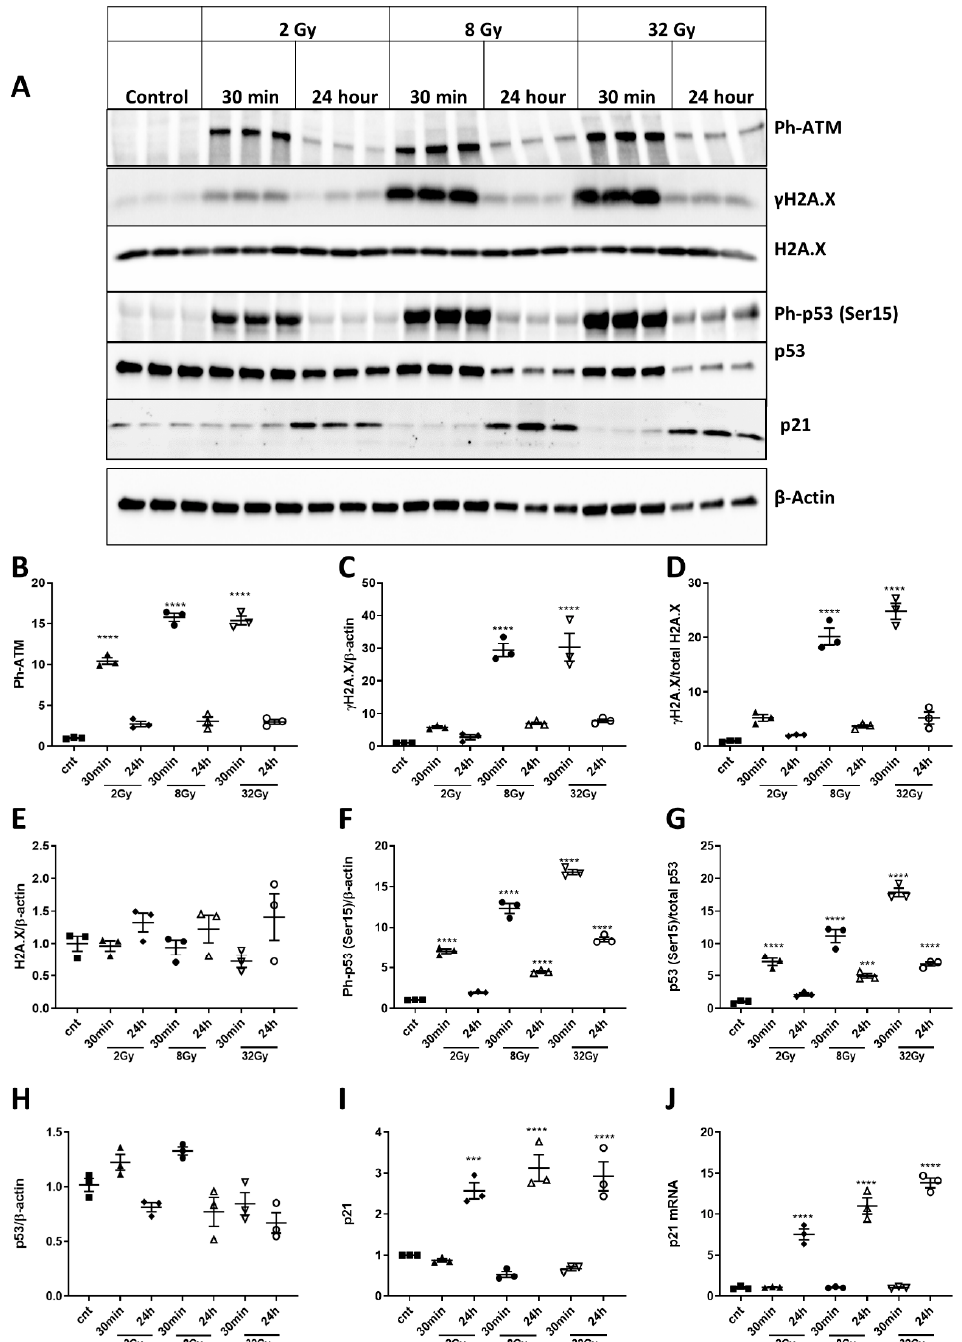
Figure 3. Ionizing radiation (IR) induces rapid and dose-dependent activation of DNA-damage and p53 pathways in primary cortical neurons. ( A ) Western blots for Ph-ATM(Ser 1981), γ -H2A.X, p53 and p21. ( B ) Ph-ATM (Ser1981) (F(6,14) = 246.4, p < 0.0001 for 30 min 2, 8 and 32Gy, compared to control; p = 0.0384 for 24 h 8Gy, p = 0.0483 for 24 h 32Gy, compared to control; p < 0.0001 for 24 h groups, compared to 30 min for 30 min 8Gy, compared to 30 min 2Gy. ( C ) γ -H2A.X (F(6,14) = 47.02, p < 0.0001 for 30 min 8 and 32Gy compared, to control; p < 0.0001 for 30 min 8Gy compared to 30 min 2Gy). ( D ) γ -H2A.X normalized to total H2A.X (F 6,14) = 102.2, p < 0.0001 for 30 min 8 and 32Gy, compared to control; p < 0.0001 for 30 min 8Gy, compared to 30 min 2Gy; p = 0.045 for 30 min 32Gy, compared to 30 min 8Gy). ( E ) H2A.X normalized to β -actin. ( F ) Ph-p53 (F(6,14) = 351.5, p < 0.0001 for 30 min 2, 8 and 32Gy, and for 24 h 8 and 32Gy; p < 0.0001 for 8Gy compared to 2Gy and 32Gy, compared to 8Gy at 30 min; p = 0.0006 for 24 h